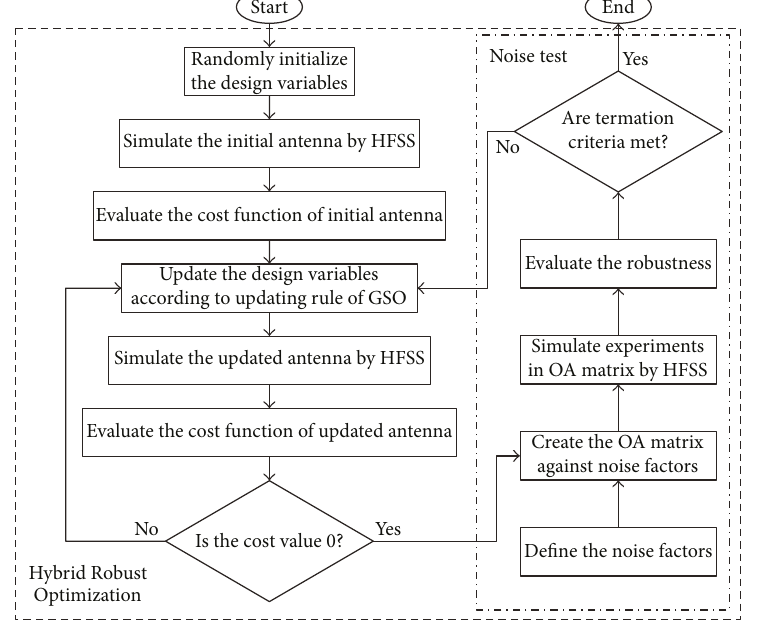
Figure 2: Flow chart of the proposed hybrid robust optimization Table 1: Optimization range of design variables.